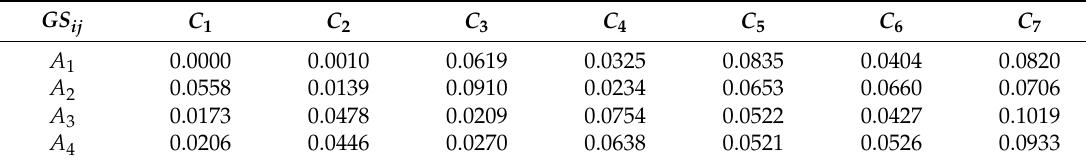
Table 6. The global scores of each alternative.